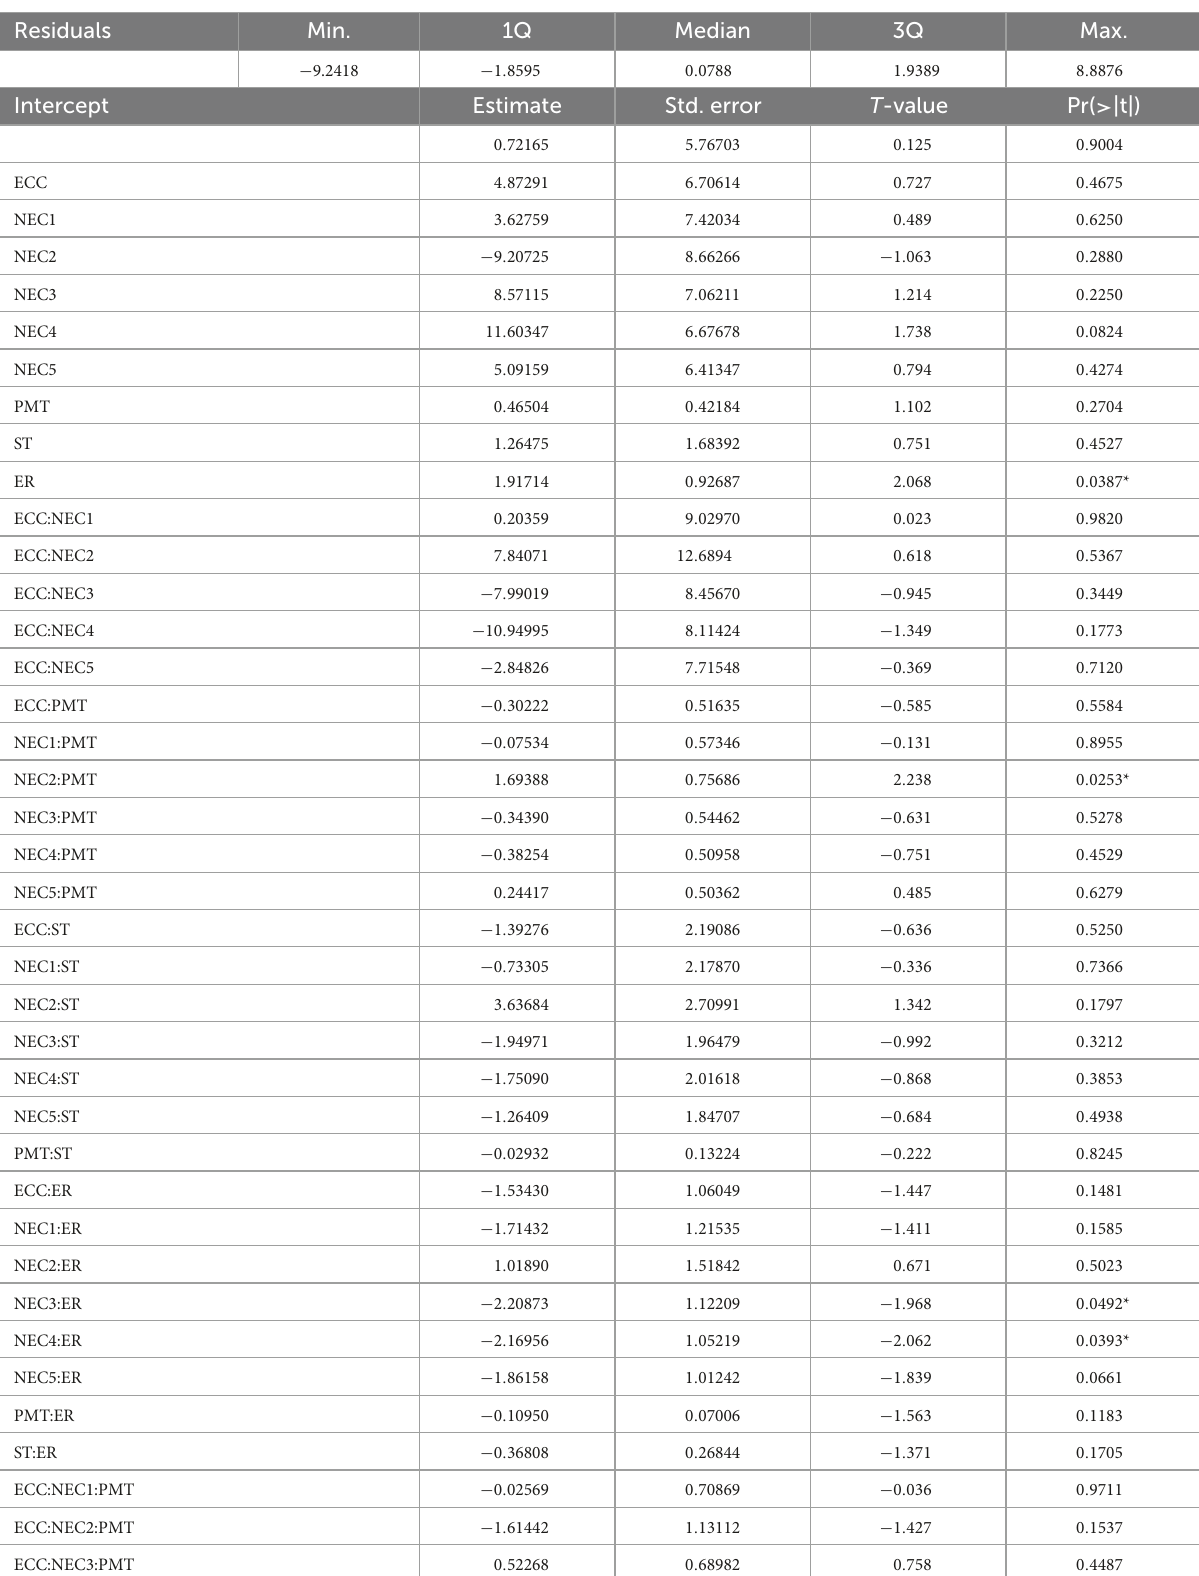
TABLE 2 Linear regression model for the motivation (MO) variable. Residuals